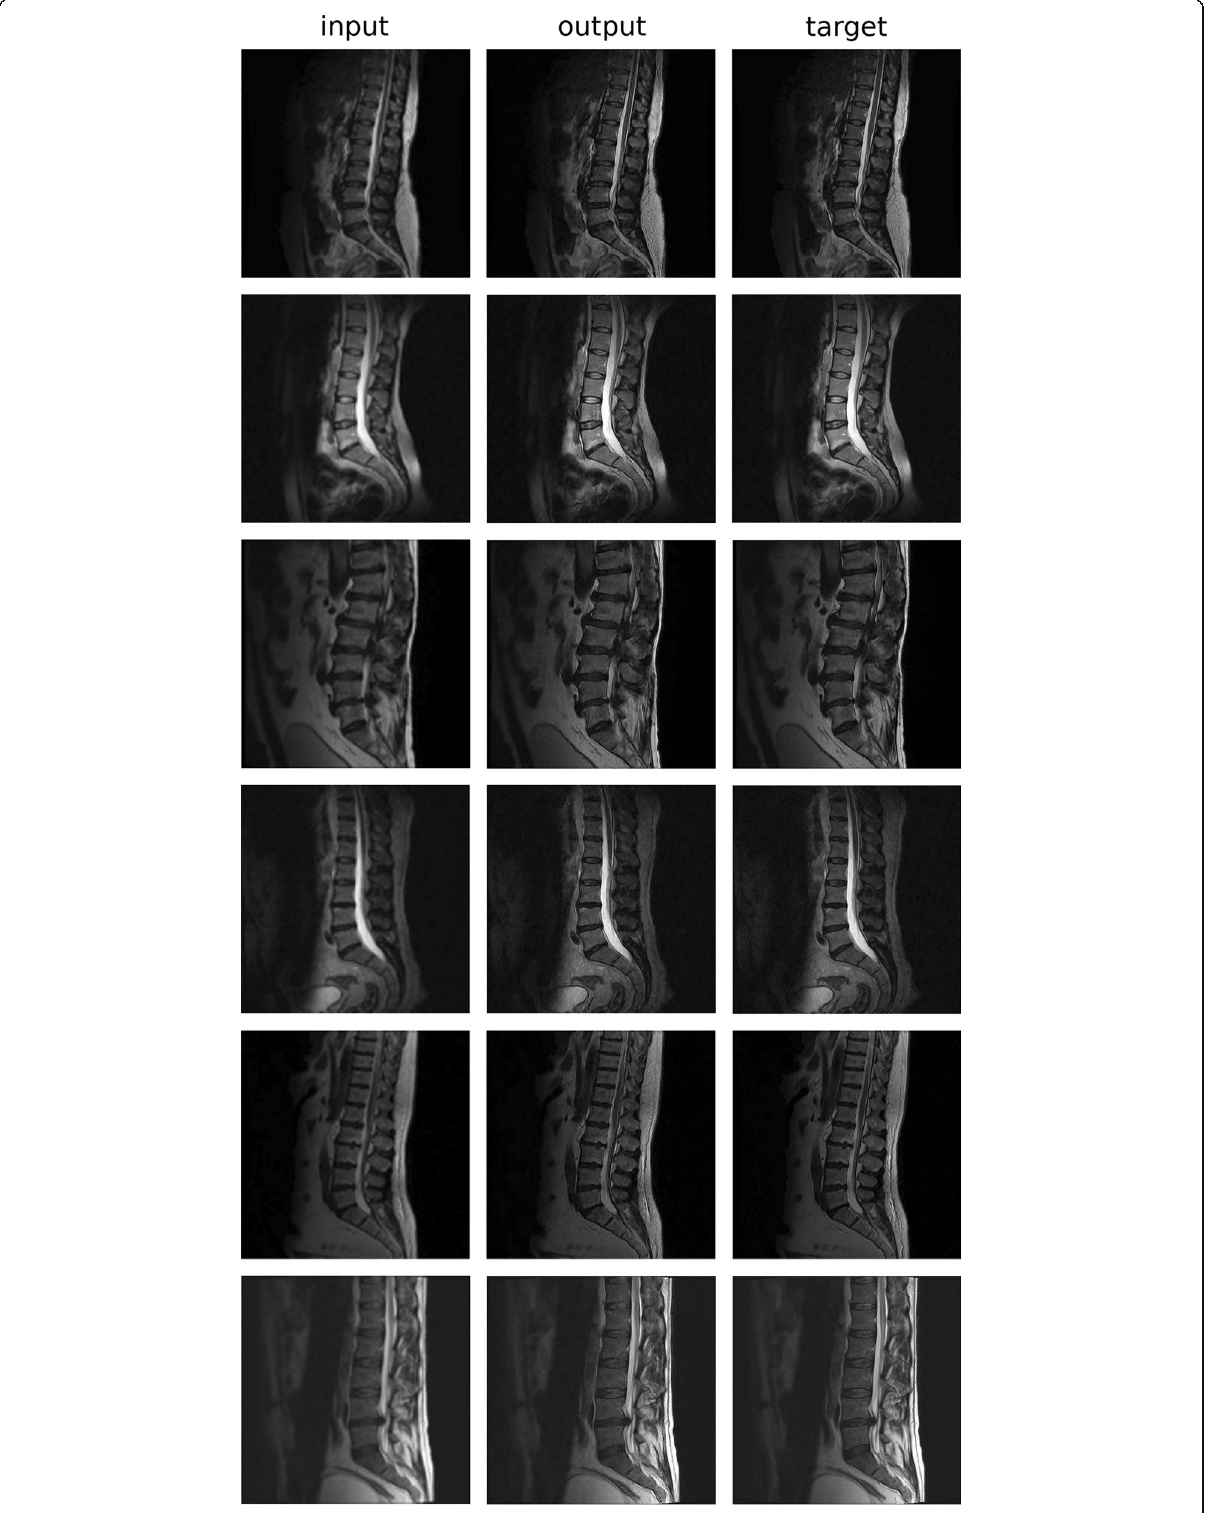
Fig. 2 Six examples of the use of GANs for the super-resolution task. input: original low-resolution image; output: output of the generative model; target: original high-resolution image. Multiple parallel edges similar to truncation artifacts are visible in proximity of high-contrast